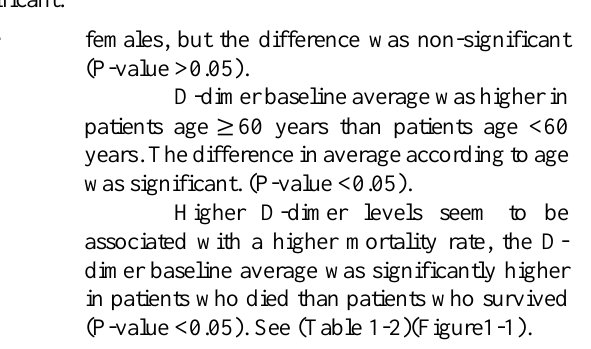
Table 2. D-dimer baseline average according to gender (male, female), age, and final status.